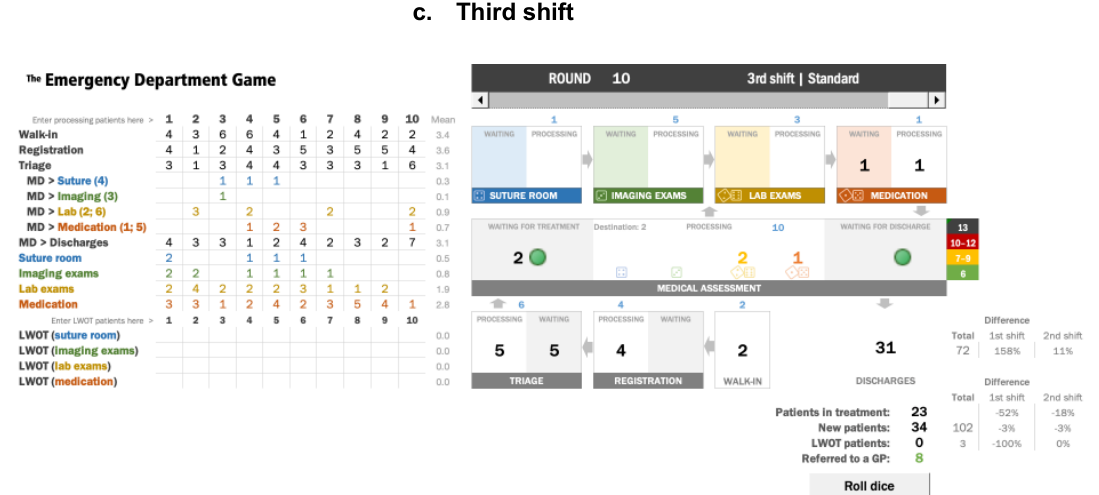
Figure 2. Game score sheets, including all the three shifts in the standard mode. ( a ) Shift 1 is equivalent to Strategy I, ( b ) Shift 2 is equivalent to Strategy IV, and ( c ) Shift 3 is equivalent to Strategy V (see the description of each strategy in Section 2.3).